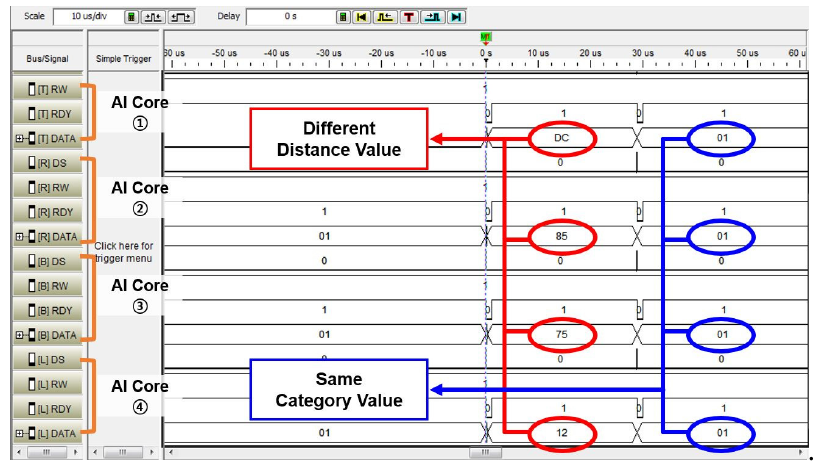
Figure 7. Image recognition results on FPGA implementation .